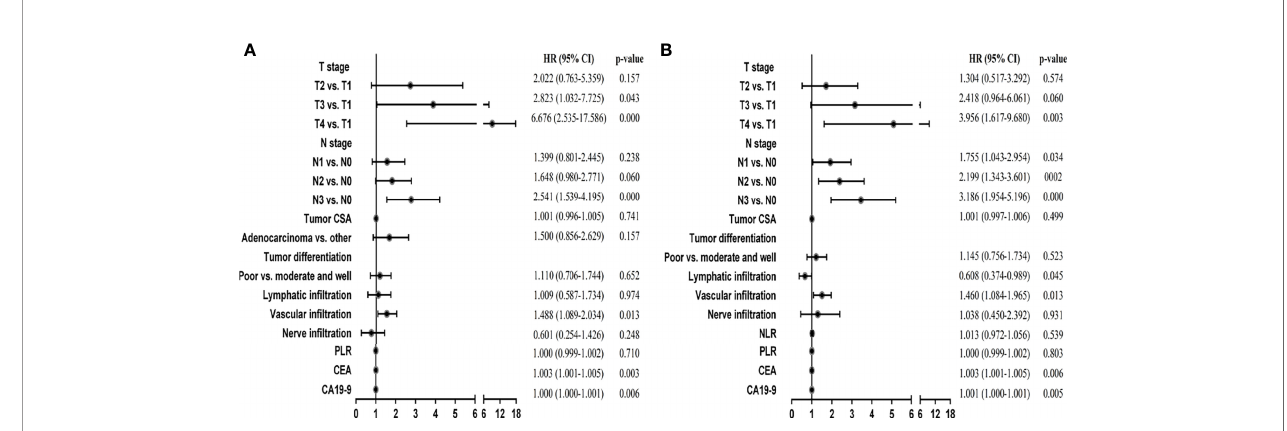
FIGURE 2 | Multivariate Cox regression analyses of stage I-III GC patients in the training cohort. (A) Multivariate Cox regression analyses for DFS. (B) Multivariate Cox regression analyses